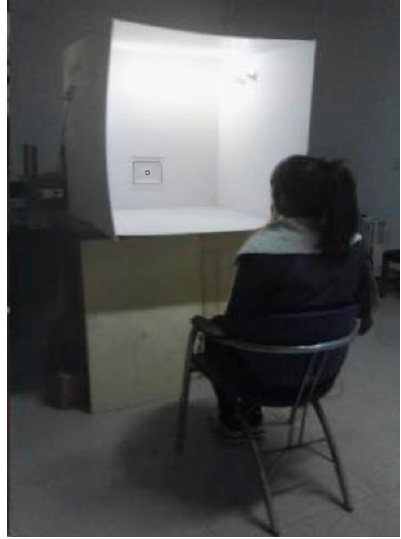
Figure 8. A photo of the experimental process.